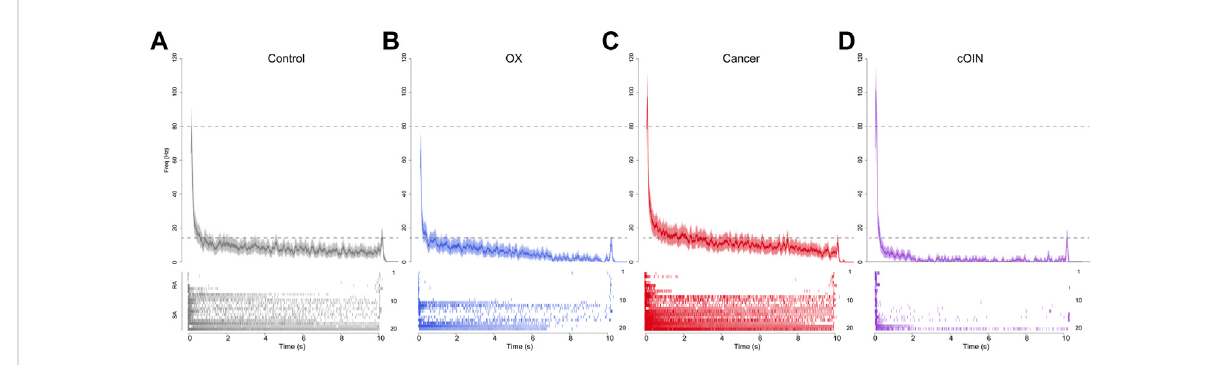
FIGURE 7 Chemotherapy for cancer impairs cutaneous population encoding. Population code of 20 neurons recorded from control (grey, (A) , OX (blue, (B) ,cancer(red, (C) ,andcOIN(purple, (D) .Rasterplotsbottompanels: (A – D) stackrepresentative fi ringresponsesof20differentafferents(1afferent per row) aligned on identical ramp-hold-release displacement applied to each afferent ’ s glabrous cutaneous receptive fi eld. Top traces show average fi ring rate (solid colored lines) and standard error (shaded region) computed per experimental group from the corresponding raster. Population codes for each group were constructed from the same distribution of afferent types: seven slowly adapting type I (SAI: Merkel corpuscles), 3 type II (SAII: Ruf fi ni endings), seven rapidly adapting Meissner corpuscles (RA RA1) and three Pacinian corpuscles (RA2